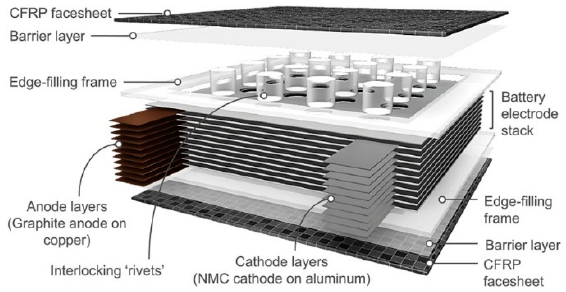
Figure 10. Multifunctional energy storage composite with interlocking rivets [27].